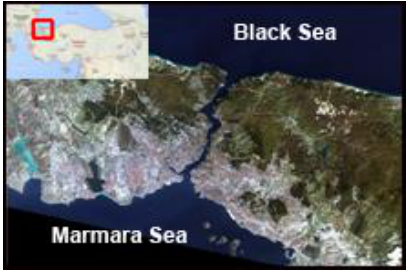
Figure 1: The satellite image and map of the study area (Landsat 8 image, 30/7/2013).